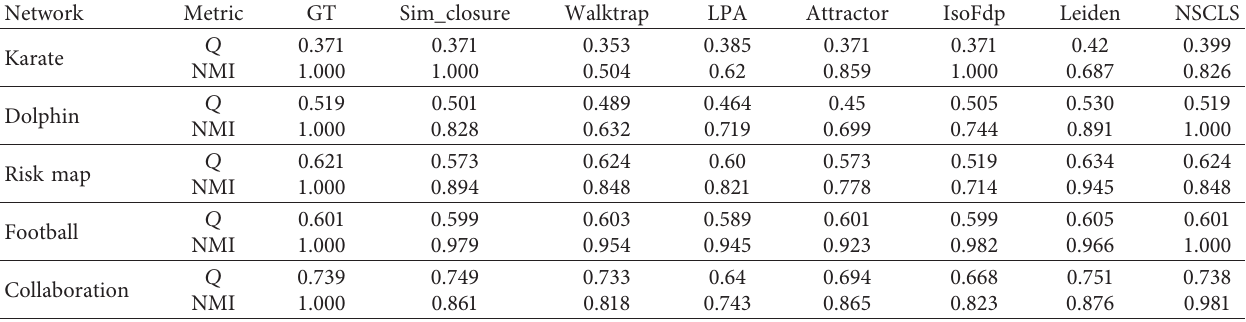
Table 3: The experimental results on the networks with ground-truth community structures. The largest values of the two indexes on each network are typed in bold, and the second largest values are marked with an